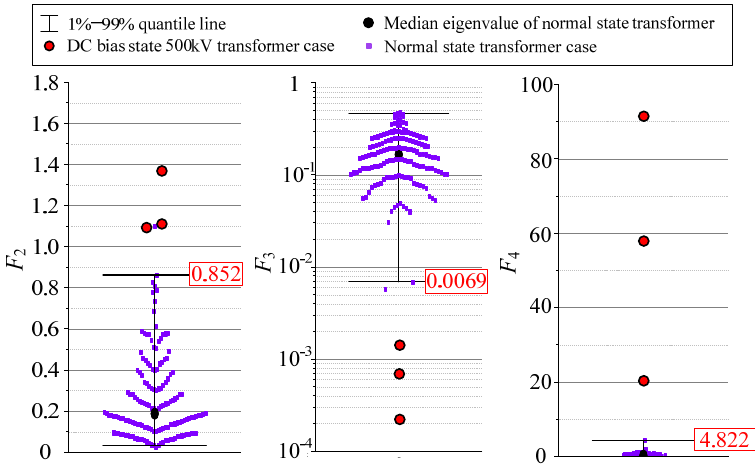
Figure 12. Comparison of typical parameters warning threshold and anomalous case.